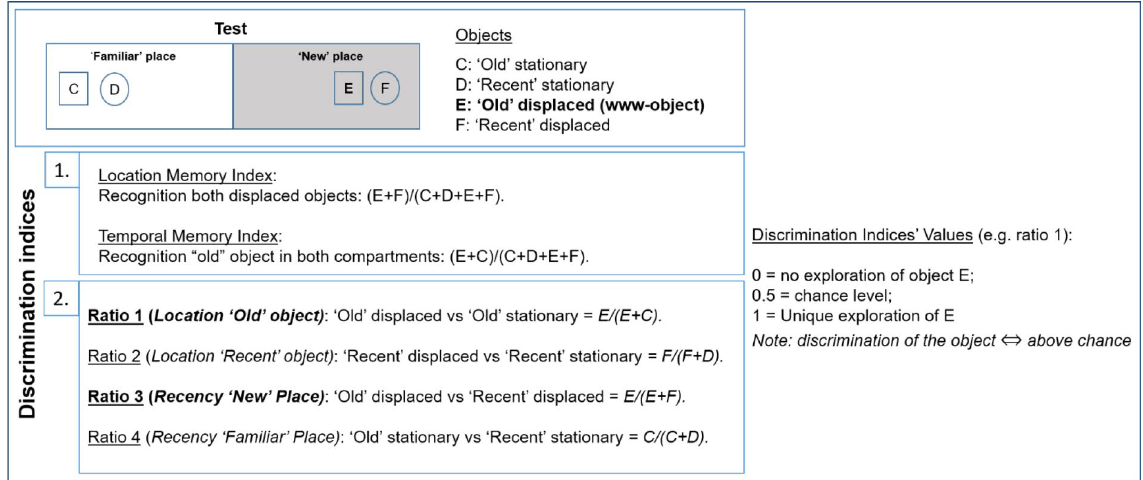
Figure 5. Discrimination indices. (1) Equations of the different discrimination indices of the test trial, related to temporal memory and location memory. (2) Single ratios related to the 2 × 2 location/recency design. In bold, ratios concerning the ‘old’ displaced object. ⇔ : if, and only